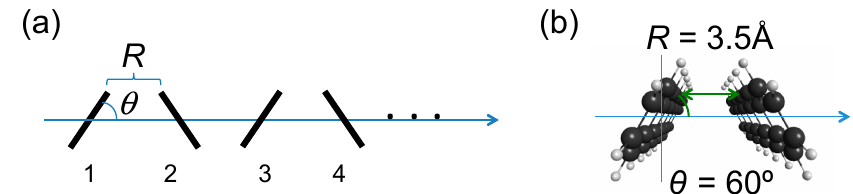
Figure 1. Linear molecular aggregate ( N -mer) model with monomer number ( a ) and its dimer ( N = 2) unit ( θ = 60°, R = 3.5 Å) ( b ).